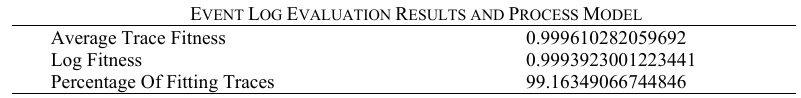
Algorithm 7. Evaluation of the fitness TABLE 4 E VENT L OG E VALUATION R ESULTS AND P ROCESS M